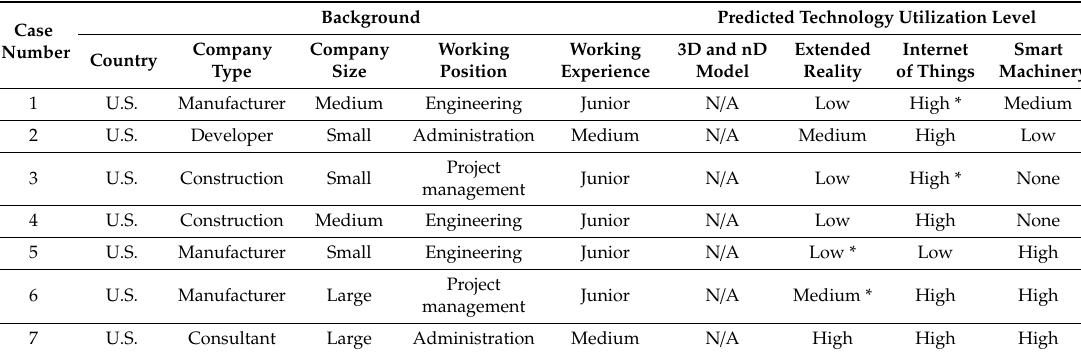
Table 7. Application of the ordinal logistic regression